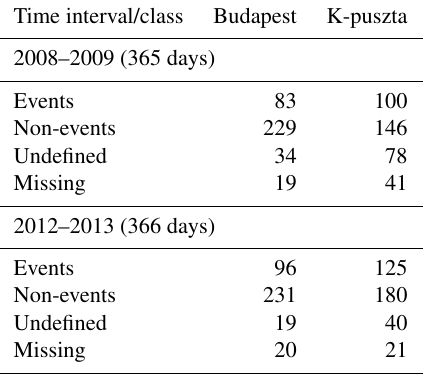
Table 1. Number of days with obvious NPF event, unambiguously no NPF event, undefined days and missing days in Budapest and at the K-puszta station for two 1-year-long time intervals in 2008– 2009 and